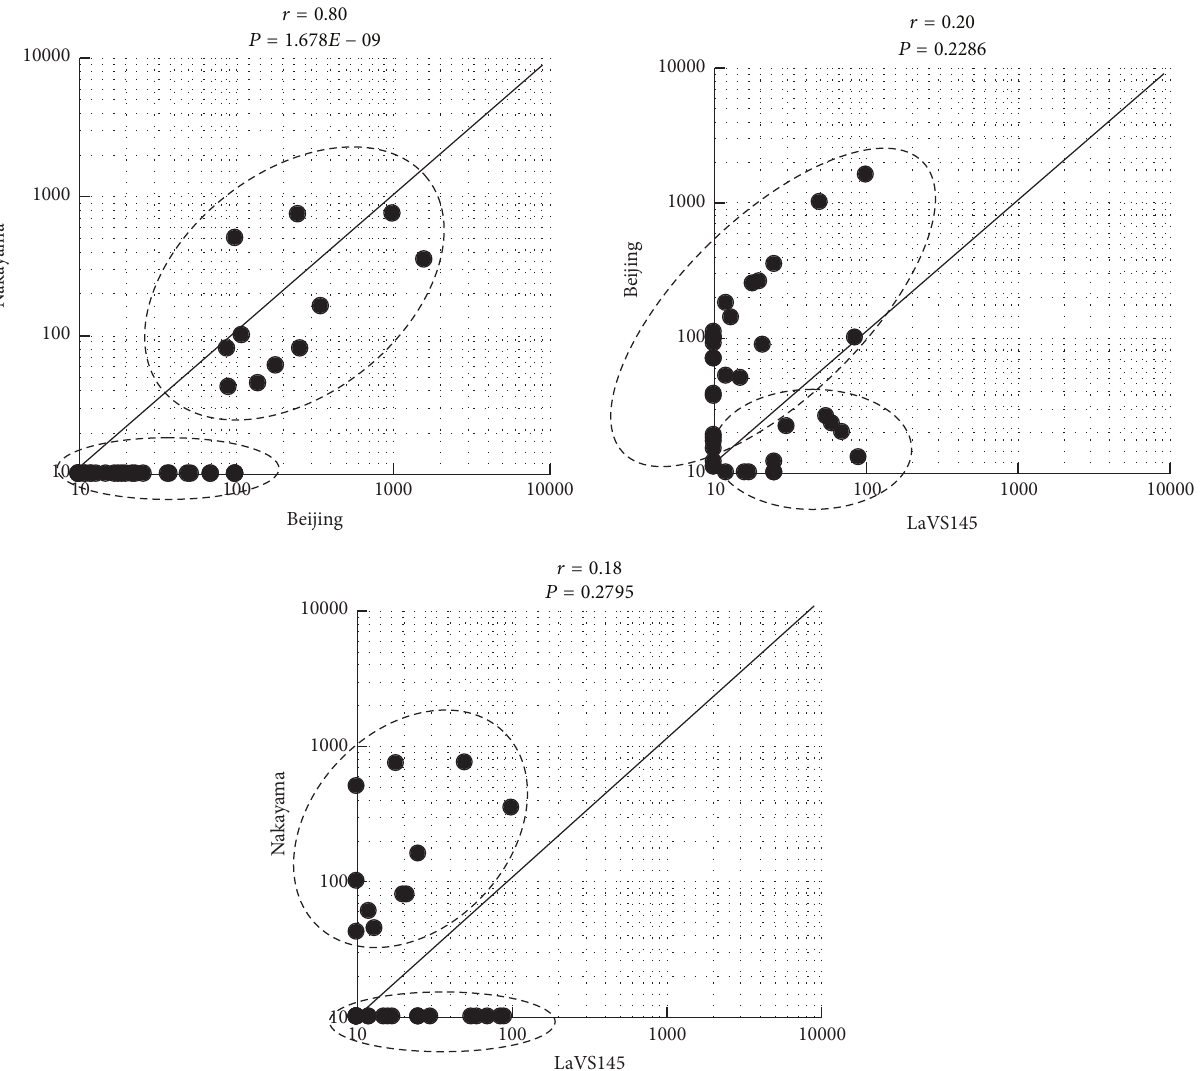
Figure 4: Correlation graphs of neutralizing antibody titers against three strains of Japanese encephalitis virus in children in Vientiane in 1994, between JEV strains. The 𝑥 - and 𝑦 -axes show neutralization titers against each strain. The correlation coefficient is described as an 𝑟 value. The result of a 𝑡 -test for each correlation coefficient is shown as a 𝑃 value. (Figure 4). The samples tended to be divided into two groups: those that neutralized Nakayama or Beijing-1 strongly